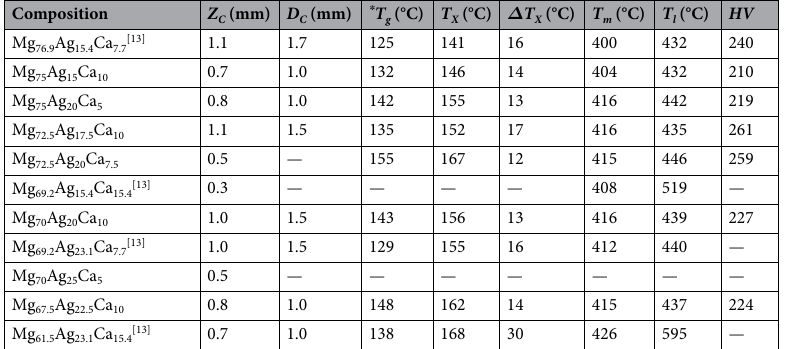
Table 1. BMG-forming compositions in the Mg-rich region of the Mg–Ag–Ca ternary system, and their associated critical casting sizes, thermophysical properties, and Vickers hardness. * T g values quoted here are the onset temperatures of the glass transition.